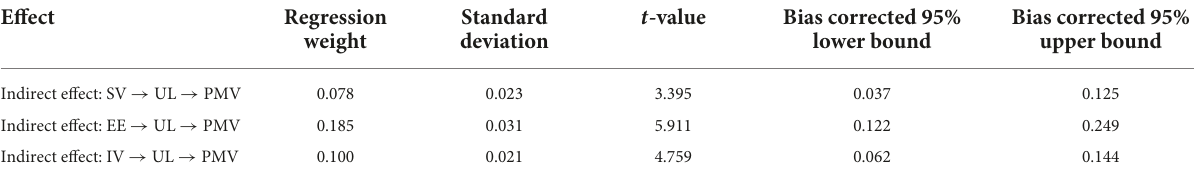
TABLE 5 The analysis of mediating